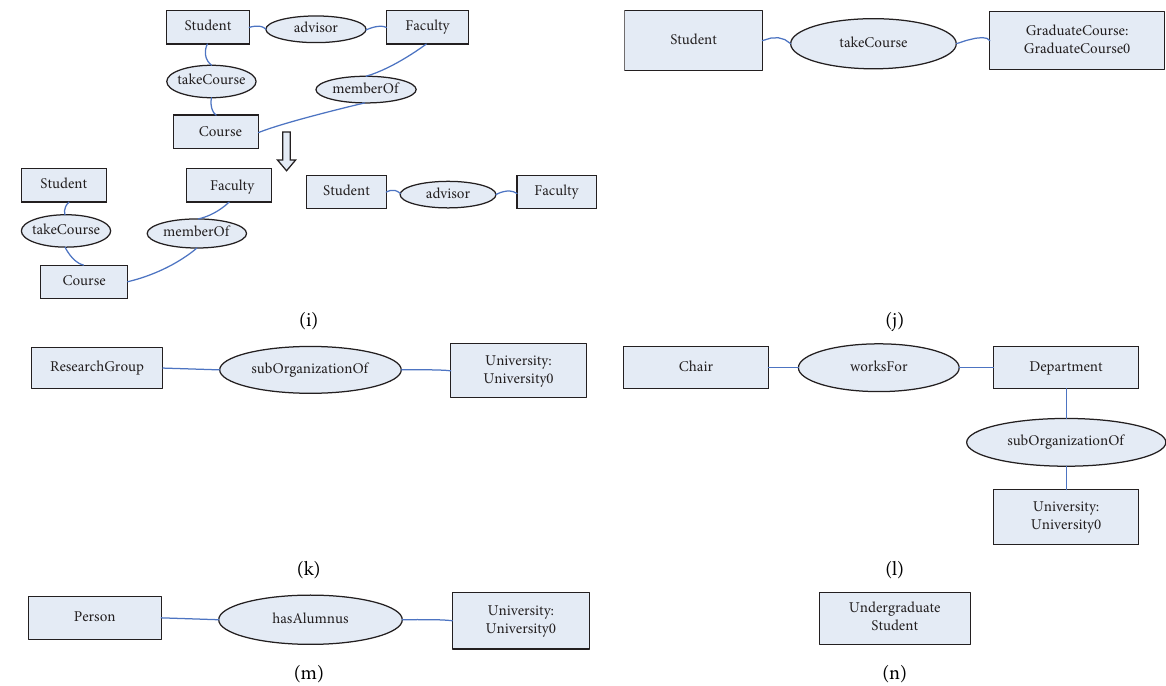
Figure 9: Graph representation of the 14 LUBM queries. (a) Query 1. (b) Query 2. (c) Query 3. (d) Query 4. (e) Query 5. (f) Query 6. (g) Query 7. (h) Query 8. (i) Query 9. (j) Query 10. (k) Query 11. (l) Query 12. (m) Query 13. (n) Query